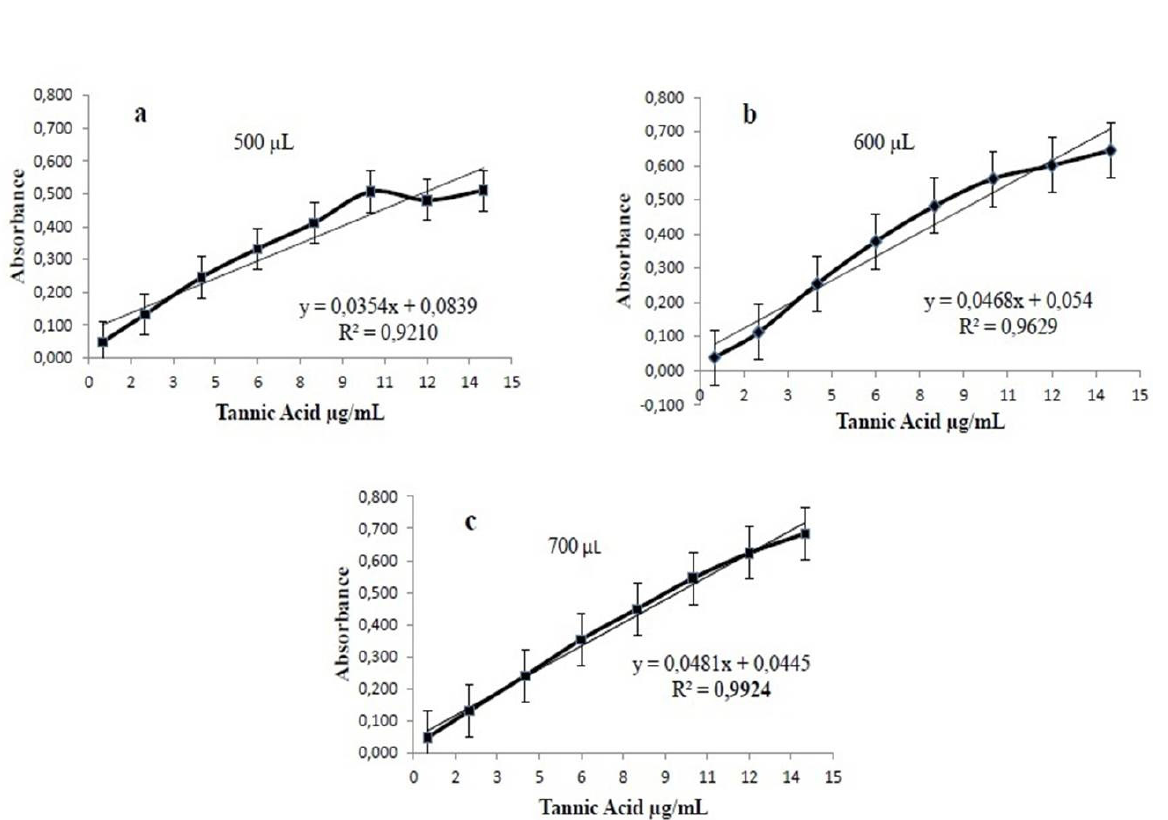
Figure 1. Standard curves built with 500, 600 and 700 μL of Folin-Ciocalteu reagent / Work data; a = Standard curve built with 500 μL of Folin-Ciocalteu reagent; b = Standard curve built with 600 μL of Folin-Ciocalteu reagent; c = Standard curve built with 700 μL of Folin-Ciocalteu